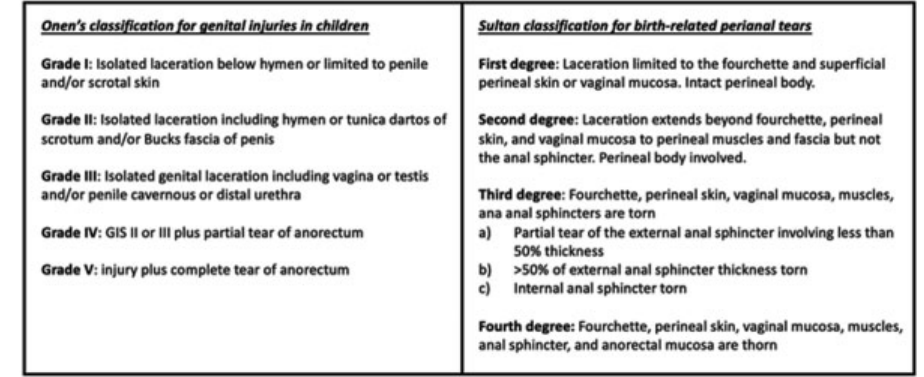
Fig. 6 The two classi fi cations used for perineal trauma. 1,8 GIS, genital injury